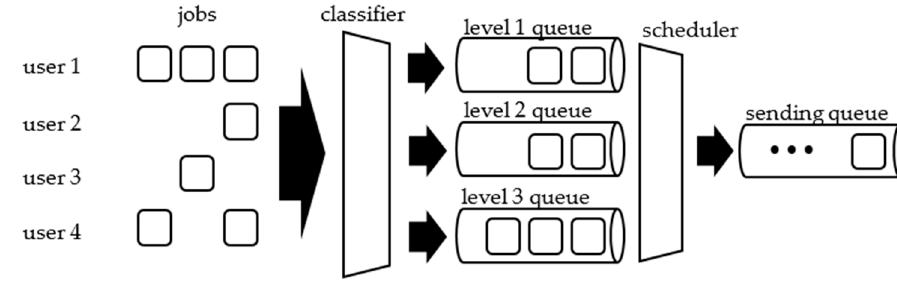
Figure 1. PQ scheduling